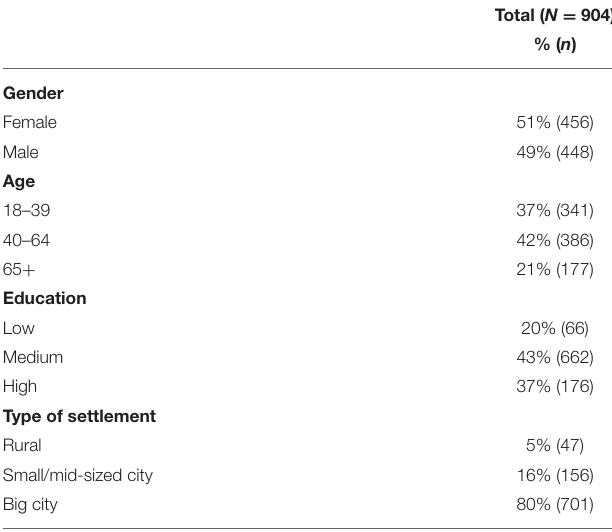
TABLE 2 | Sociodemographic characteristics of the included study population.